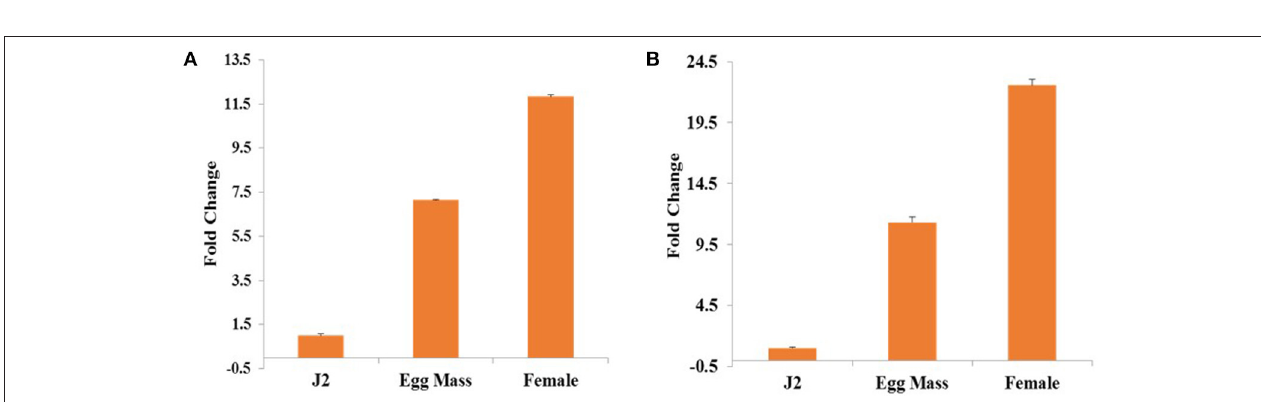
FIGURE 2 | Differential expression of (A) Mi-col-1 and (B) Lemmi-5 in different life stages of M. incognita through qRT-PCR. 18s rRNA ( M. incognita ) gene has been used as an internal control. Each bar represents the mean ± SE of n = 3.